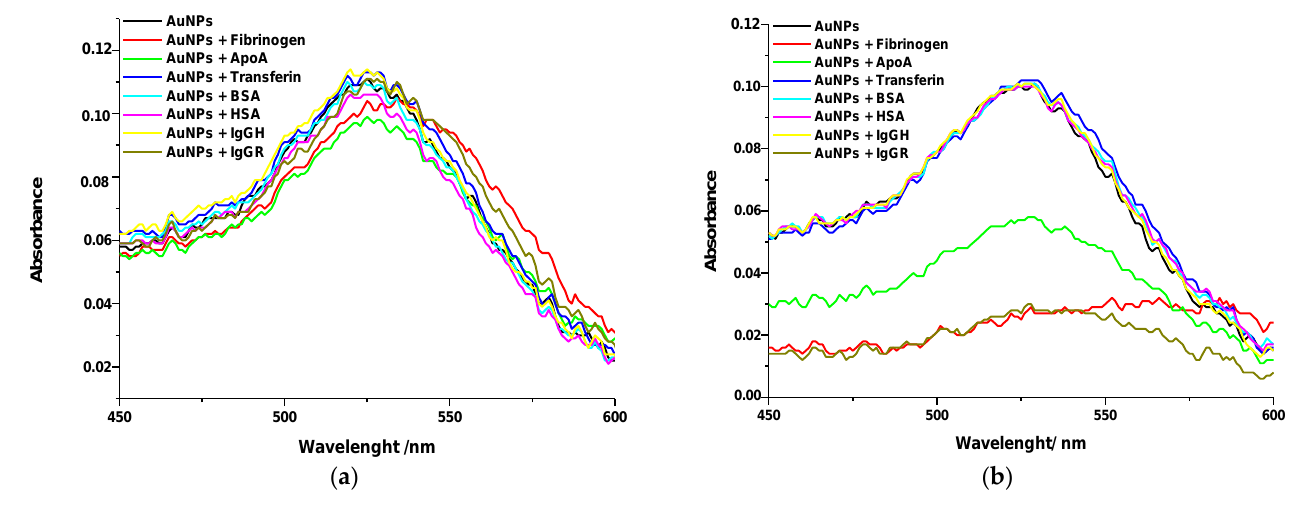
Figure 9. UV-Vis spectra of gold NPs in the presence of proteins ( a ) immediately after mixing and ( b ) after 4 h of incubation. Table 2. Values and variations of λ max and absorbance of gold and silver NPs immediately after mixing and after 4 h of incubation with proteins.